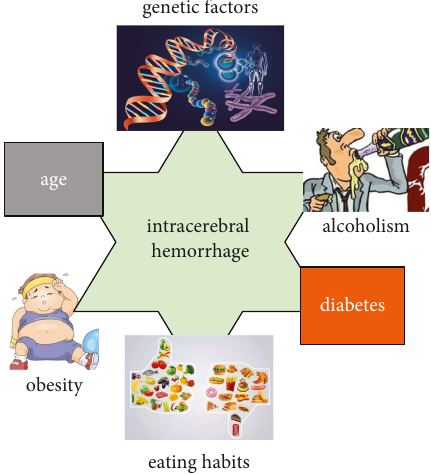
Figure 2: Causes of intracerebral